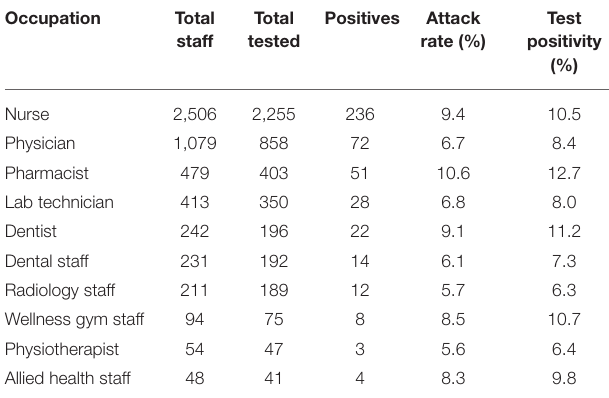
TABLE 2 | Attack rate and test positivity among clinical staff.